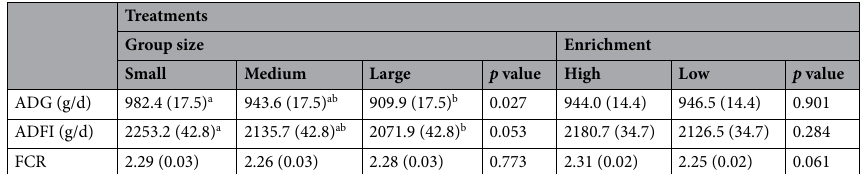
Table 4. Effect of group size and enrichment on animal performance (LSmeans ± SEM). Group size: Large (48 pigs/pen), Medium (24 pigs/pen), Small (12 pigs/pen) Enrichment: Low (Wood + Hanging toy), High (Wood + Hanging toy + Grass). abc Different letters denote significant differences picked up by Tukey–Kramer test ( p <